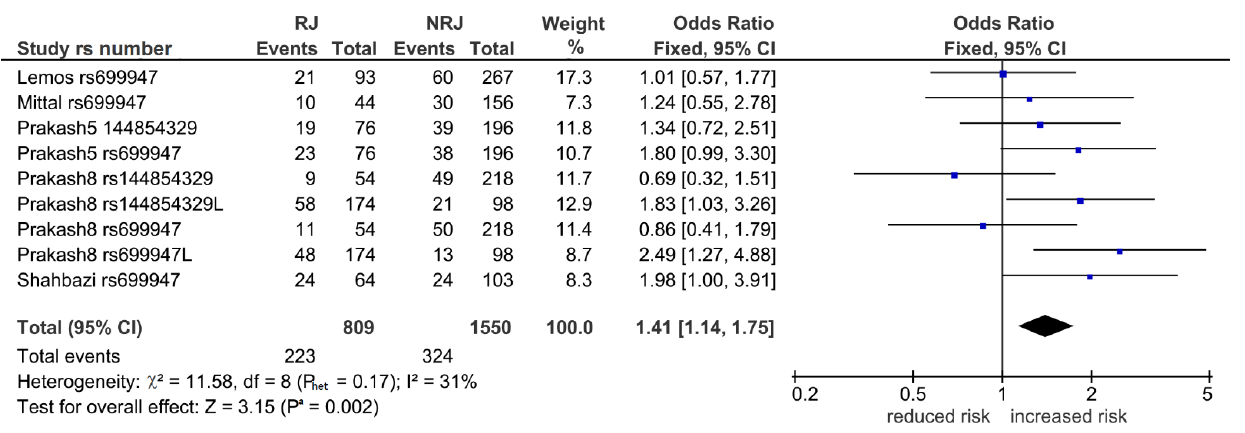
Figure 2. Forest plot in the post-outlier overall outcome for the wt allele in VEGF1 (n = 9). Diamond denotes the pooled odds ratio (OR) indicating increased risk (1.41). Squares indicate the OR in each study. Horizontal lines on either side of each square represent the 95% confidence intervals (CI). The Z test for overall effect shows significance (P a = 0.002).The χ 2 -square test outcome has low-level heterogeneity (P = 0.17, I 2 = 31%). wt : wild-type; VEGF : vascular endothelial growth factor; I 2 : a measure of variability expressed in %; RJ: rejection; NRJ: het non-rejection, L: